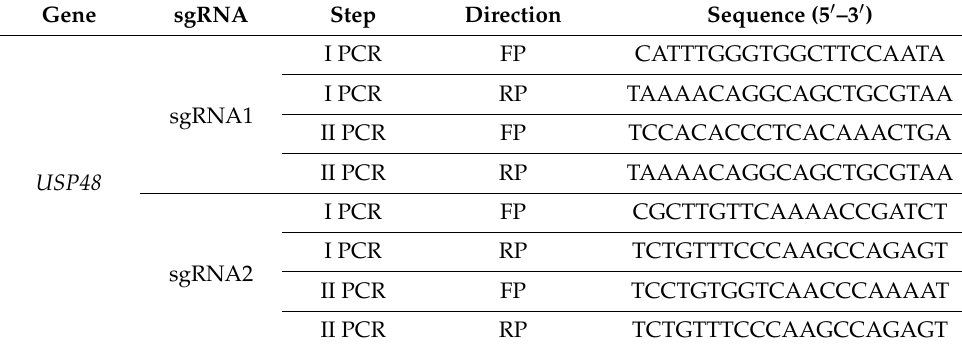
Table 1. Oligonucleotides used to amplify PCR targets for T7E1 assay.